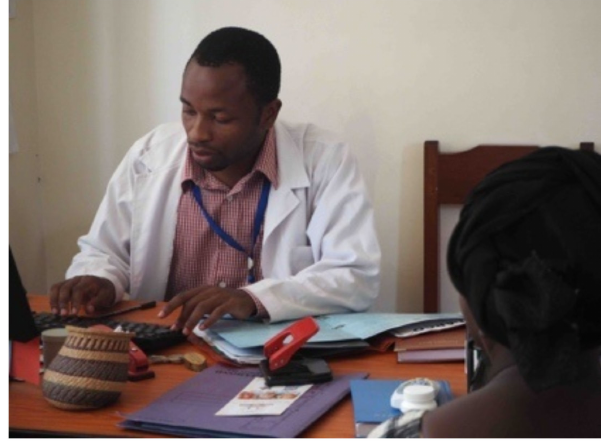
Figure 2. Consultation at the CDCI, Dr Ezekiel Luoga (head of CDCI, co-author).